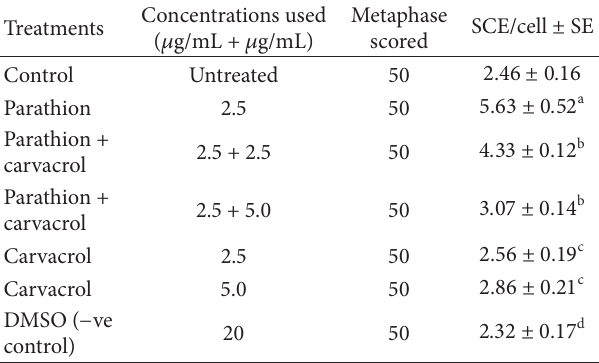
Table 3: Protective effect of carvacrol against parathion treated cultured human peripheral blood